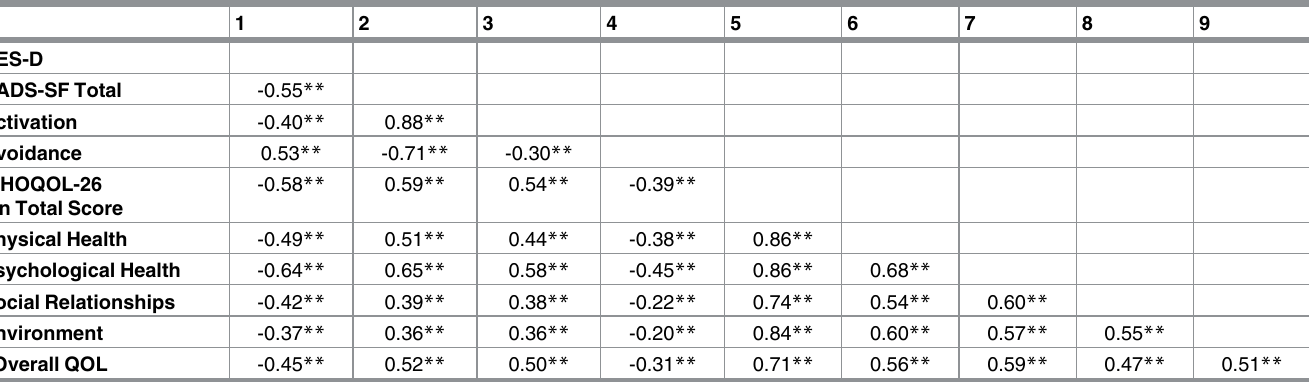
Table 2. Correlations between measures( N =